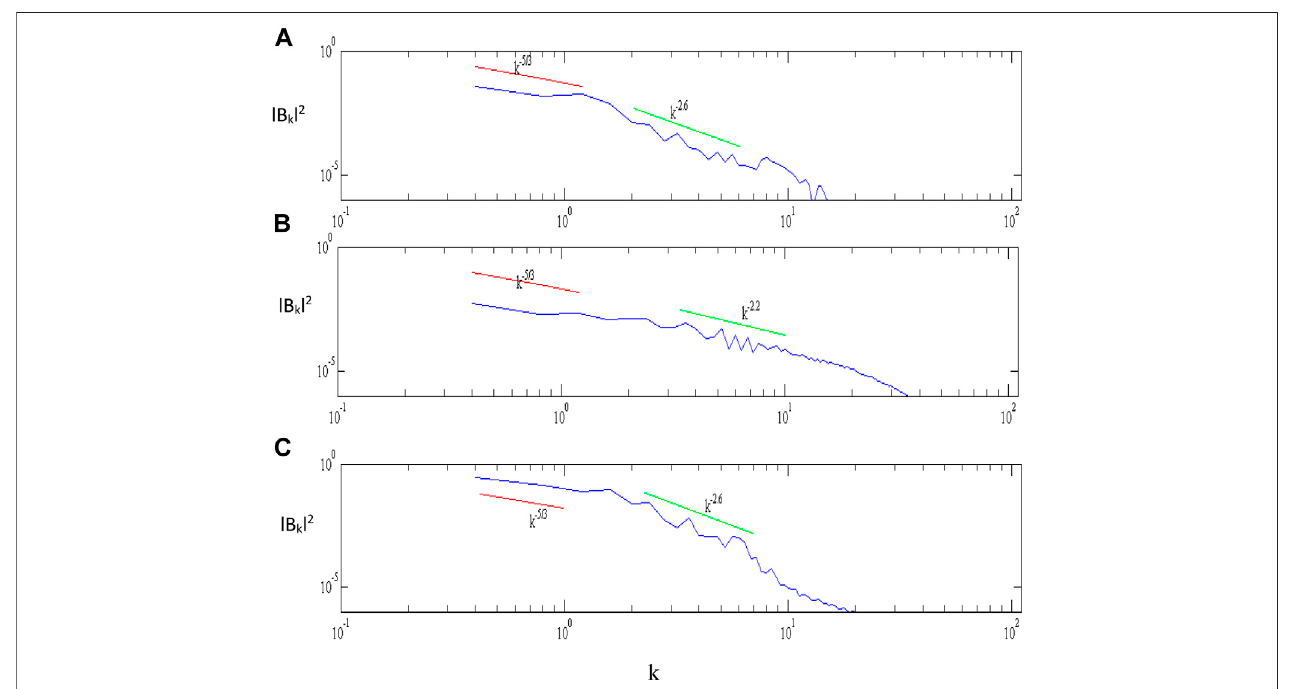
( normalizedwith ρ ) . (A) WithIC-1att=15. (B) WithIC-2att=17. (C) With s B 2 n againstk